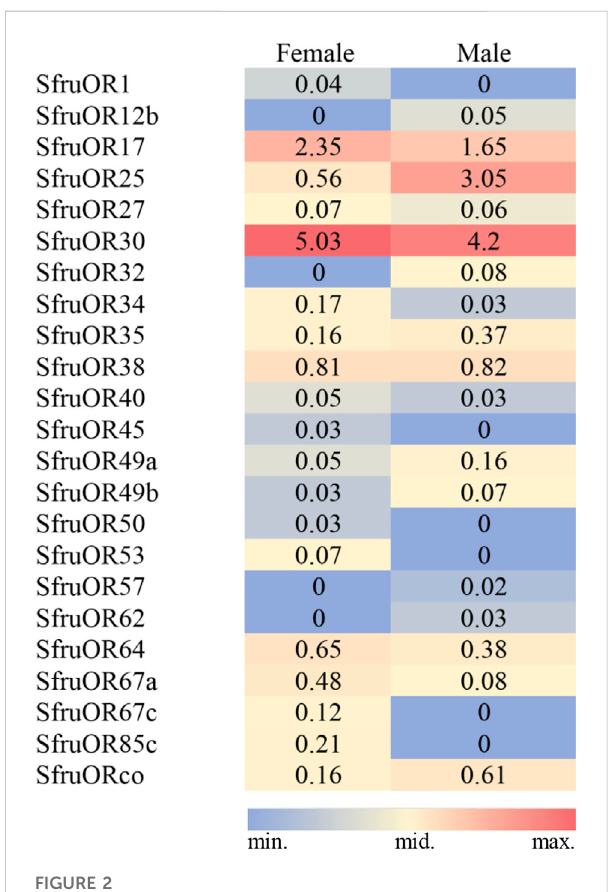
FIGURE 2 TPM values of candidate SfruORs in the tarsi of male and female S . frugiperda